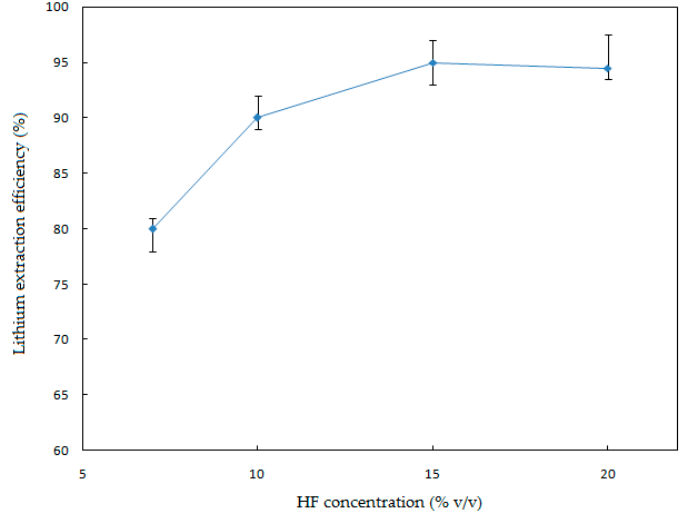
Figure 5. Effect of HF concentration on the Li extraction efficiency.